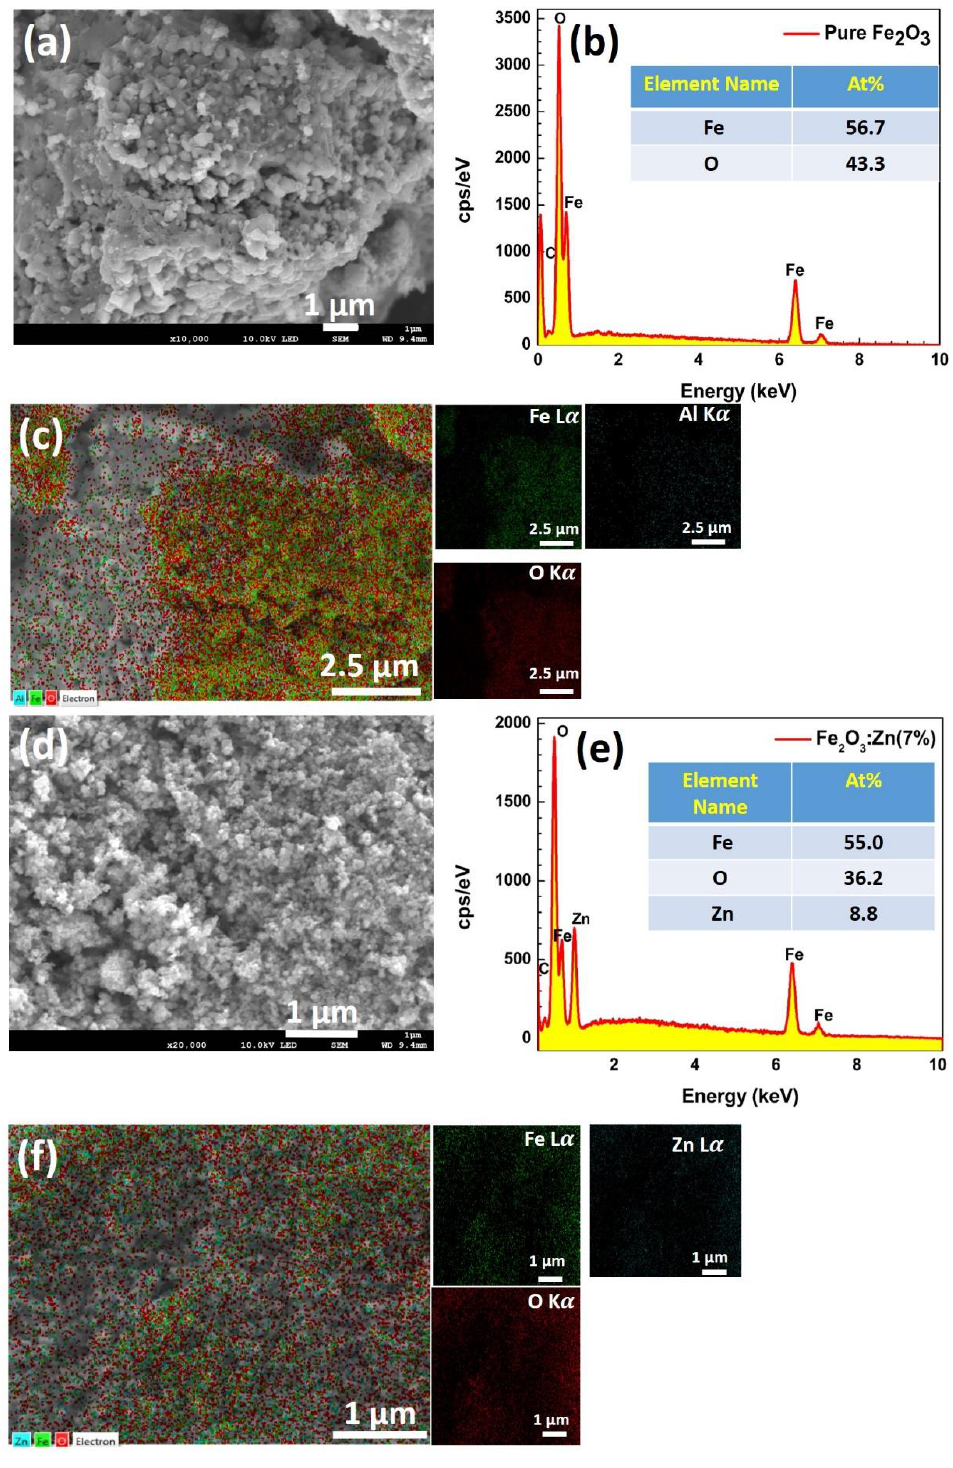
Figure 3. SEM micrograph: ( a ) pure Fe 2 O 3 and ( d ) Zn 7 %: Fe 2 O 3, respectively; ( b , e ) are their EDS spectra, respectively, while ( c , f ) represent their respective color − mapping for elemental detection.